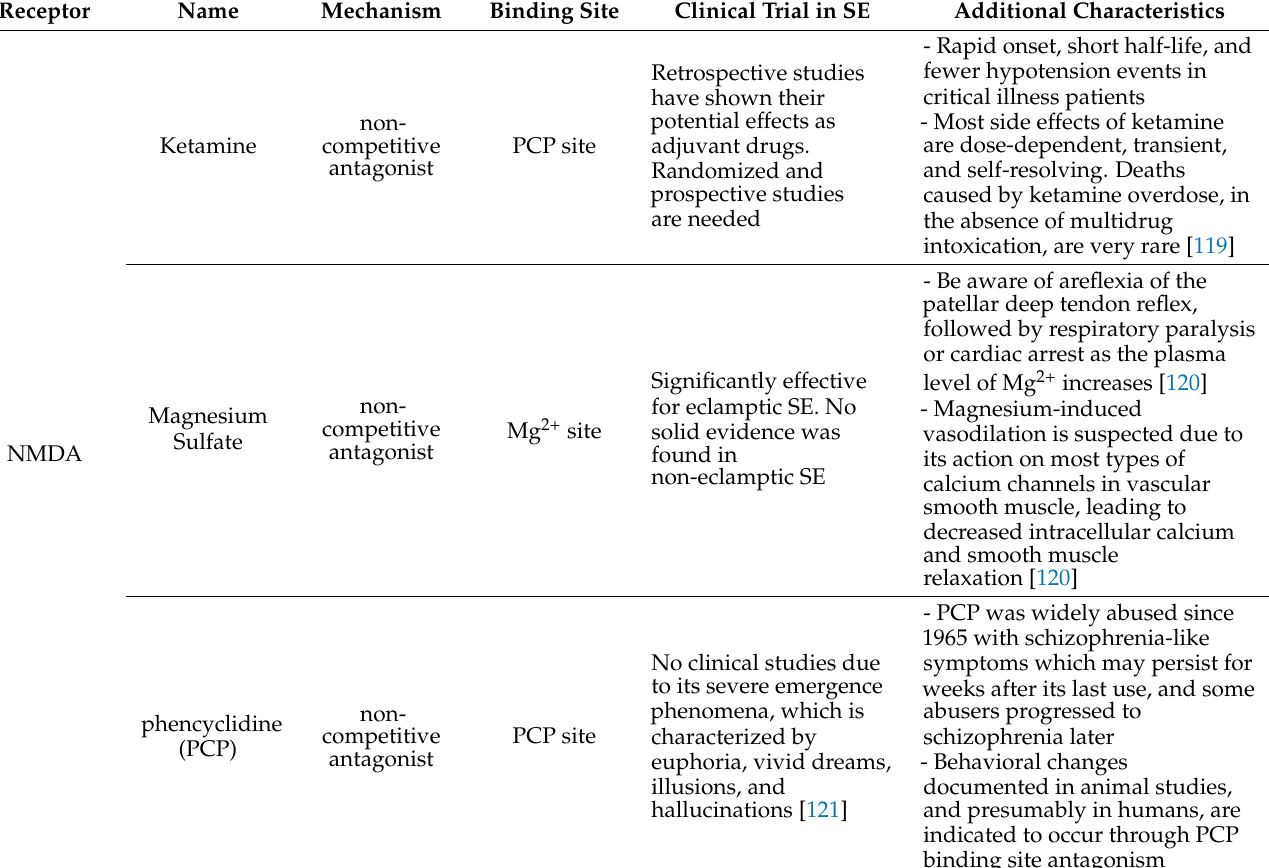
Table 1. The various compounds (NMDA and AMPA antagonists), their trials on SE, and